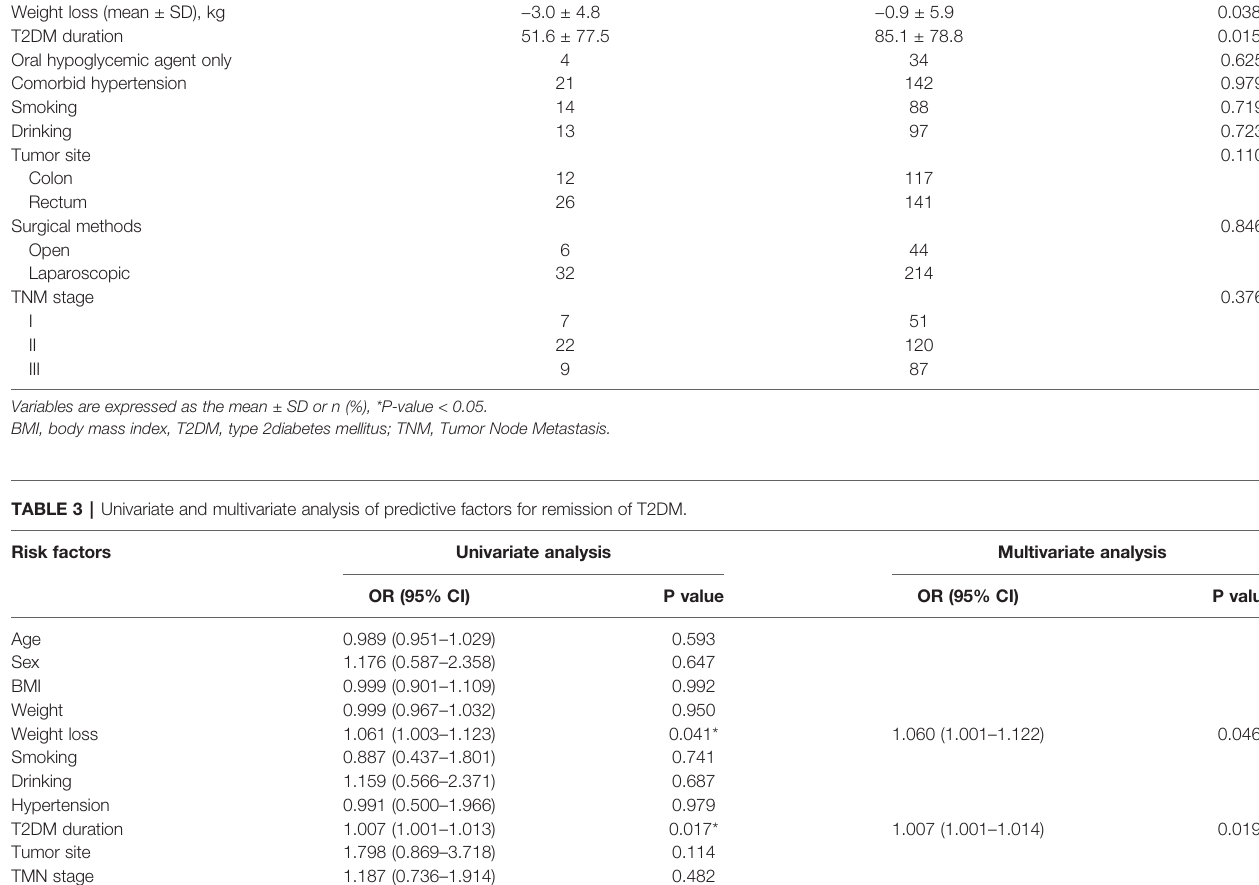
TABLE 2 | Difference between remission and no remission group.